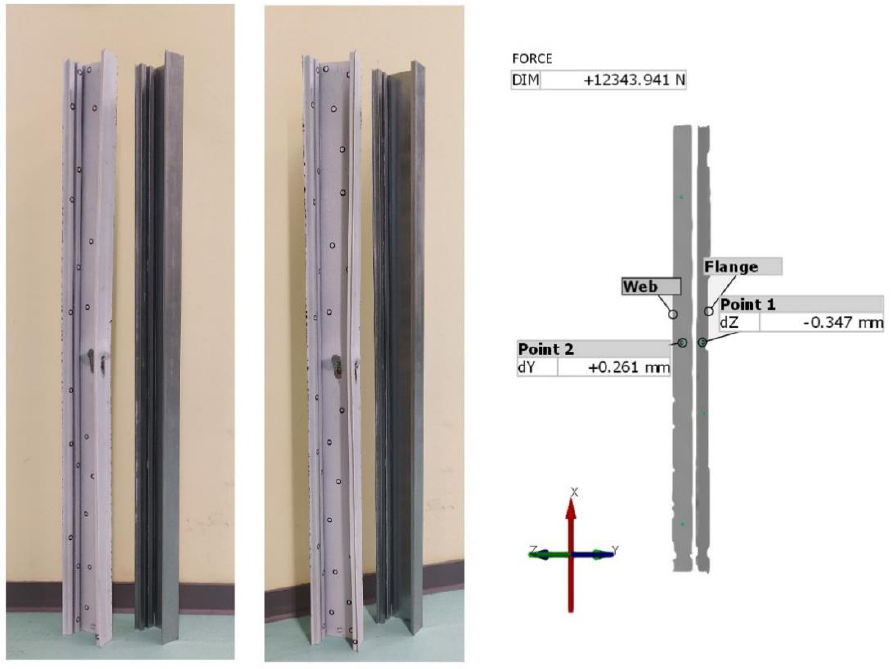
Figure 9. Location of measurement points on the surface of the tested column. GOM Correlate program.